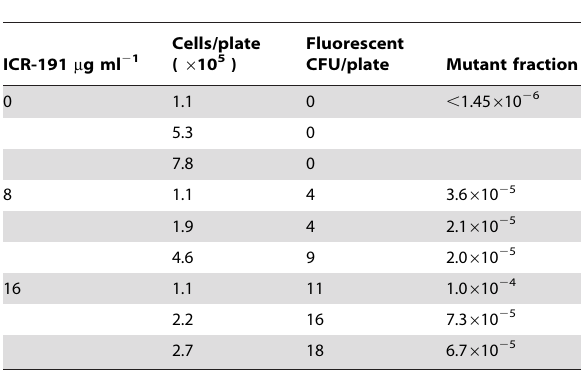
Table 1. Influence of mutagen dose levels on mutation rate in P. aeruginosa assessed by pMDGFP FIM fluorescent colony